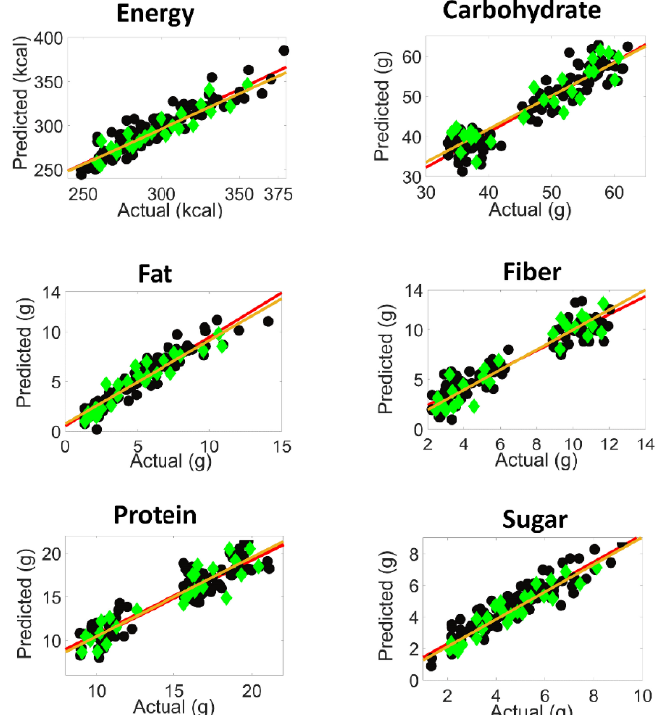
Figure 5. Graphs of the predicted versus actual content of the respective nutritional parameter per serving (calibration fit ( ), prediction fit ( ), calibration samples ( ) and predicted test set samples ( )). Table 2. Content Range and statistical parameters obtained for the individual PLS models of the nutritional parameters.